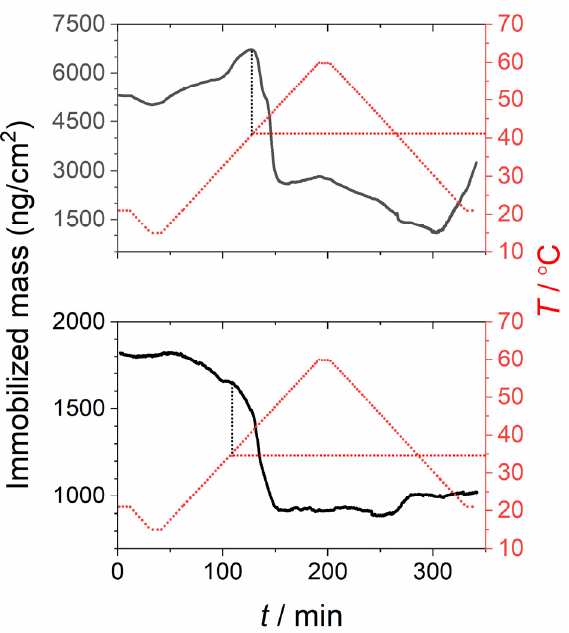
Figure 11. Effect of temperature on the mass (as determined by QCM-D) of immobilized liposome layers formed by DPPC ( top ) and by DPPC:DSPE-PEG2000 with a molar fraction of 96:4 ( bottom ).